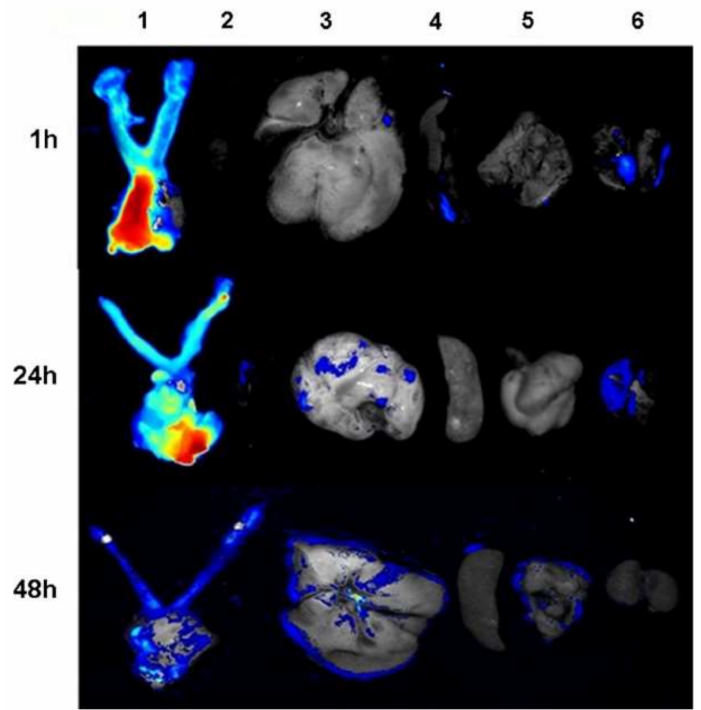
Figure 2. Ex vivo imaging of collected organs (1 tumor, 2 hearts, 3 livers, 4 spleens, 5 lungs and 6 kidneys) at 1, 24 and 48 h following the implantation of electrospun nanofibers into the mice’s vaginas. Reprinted with permission from ref.